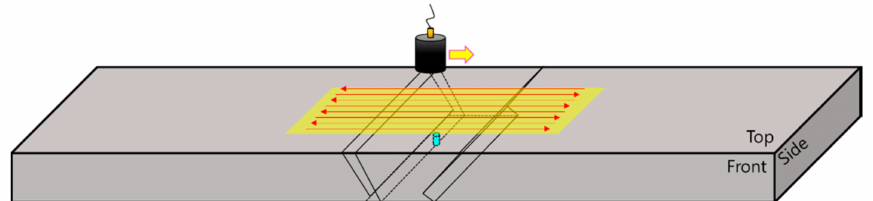
Figure 16. Experimental setup for detecting a crack in a welded specimen of di ff erent metals by ultrasonic vertical